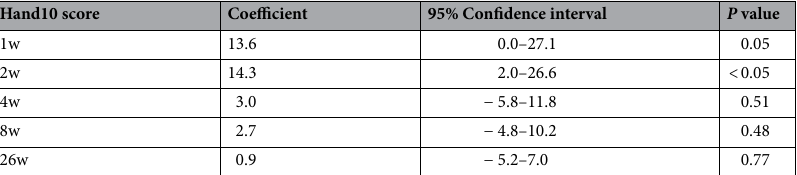
Table 2. Results of Hand10 score after propensity-score adjusted generalized linear modeling to compare outcomes between Collagenase and Surgery groups. Coefficients (and their 95% confidence intervals) indicate the degree of each outcome in the Surgery group with reference to the Collagenase group. w,